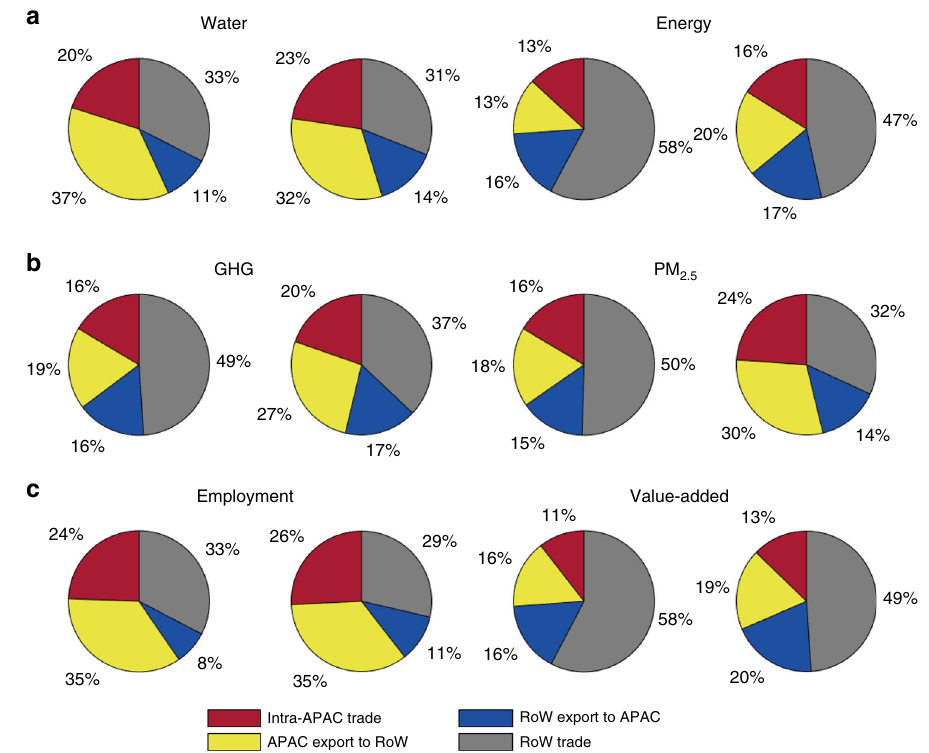
Fig. 3 Natural resources, environmental emissions, and socio-economic factors embedded in exports. a natural resource, b local and global environmental threats, c socio-economic effects are shown in three panels. Note, the red and blue sections correspond to the same components in Fig. 1. Table 1 Intensity comparison between APAC and the global average from the footprint and trade perspectives. Global APAC APAC without China